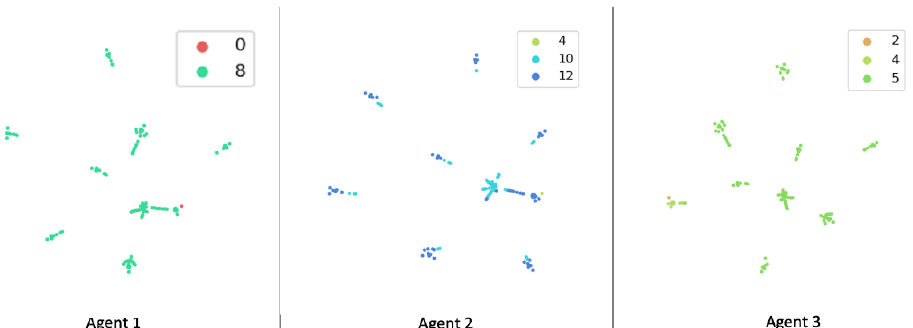
Figure 9. State representation from the 3 agents of the 50-hosts scenario. The clusters are coloured based on the action